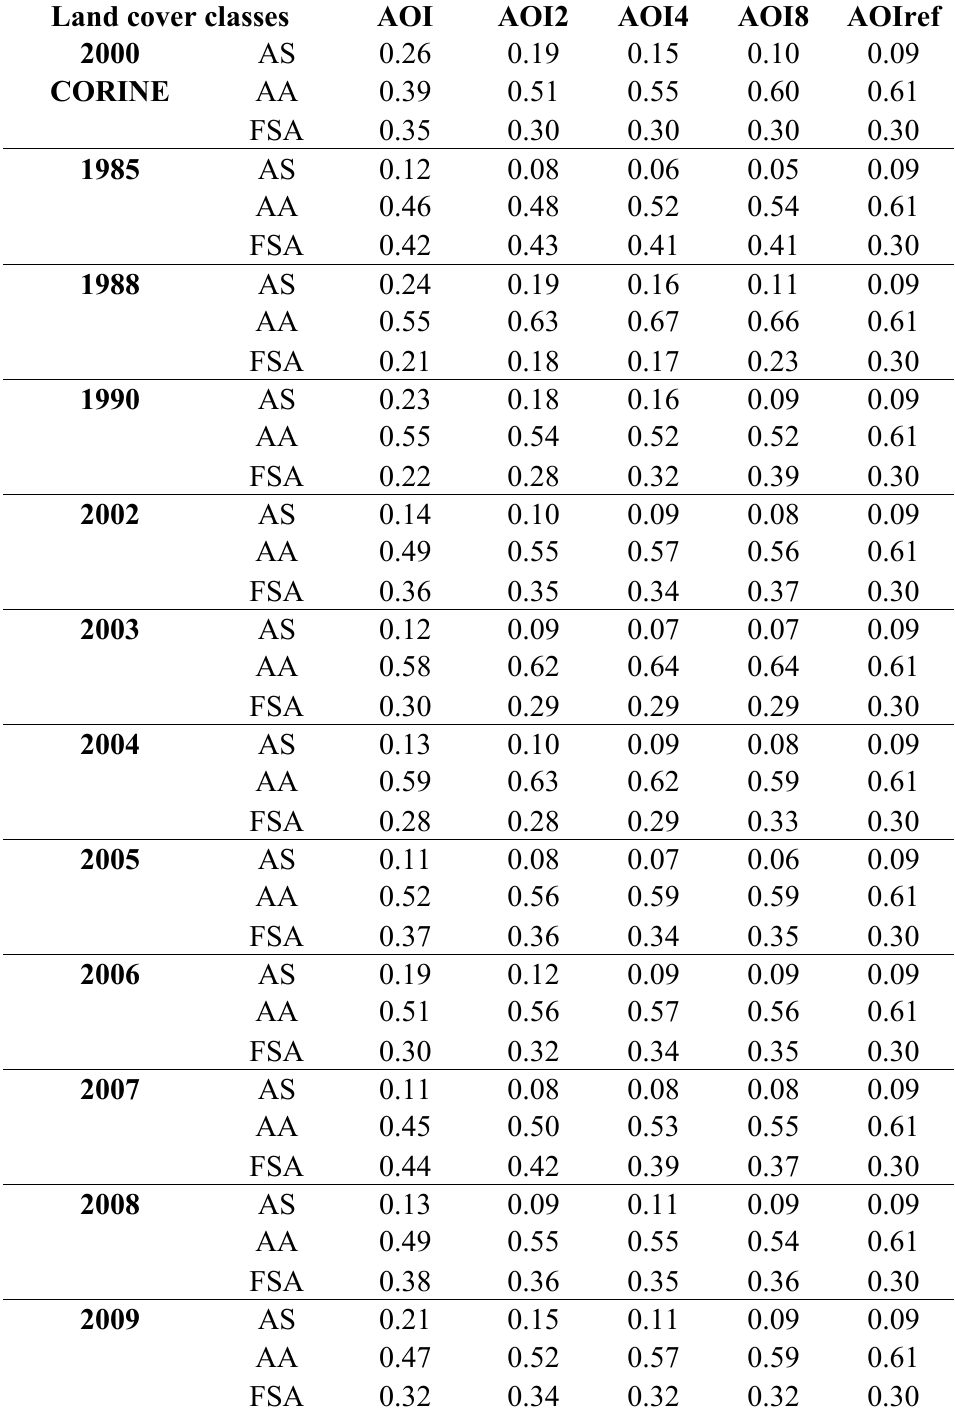
Table 1. Rates of the NDVI classes in the areas of interest AOI, AOI2, AOI4 and